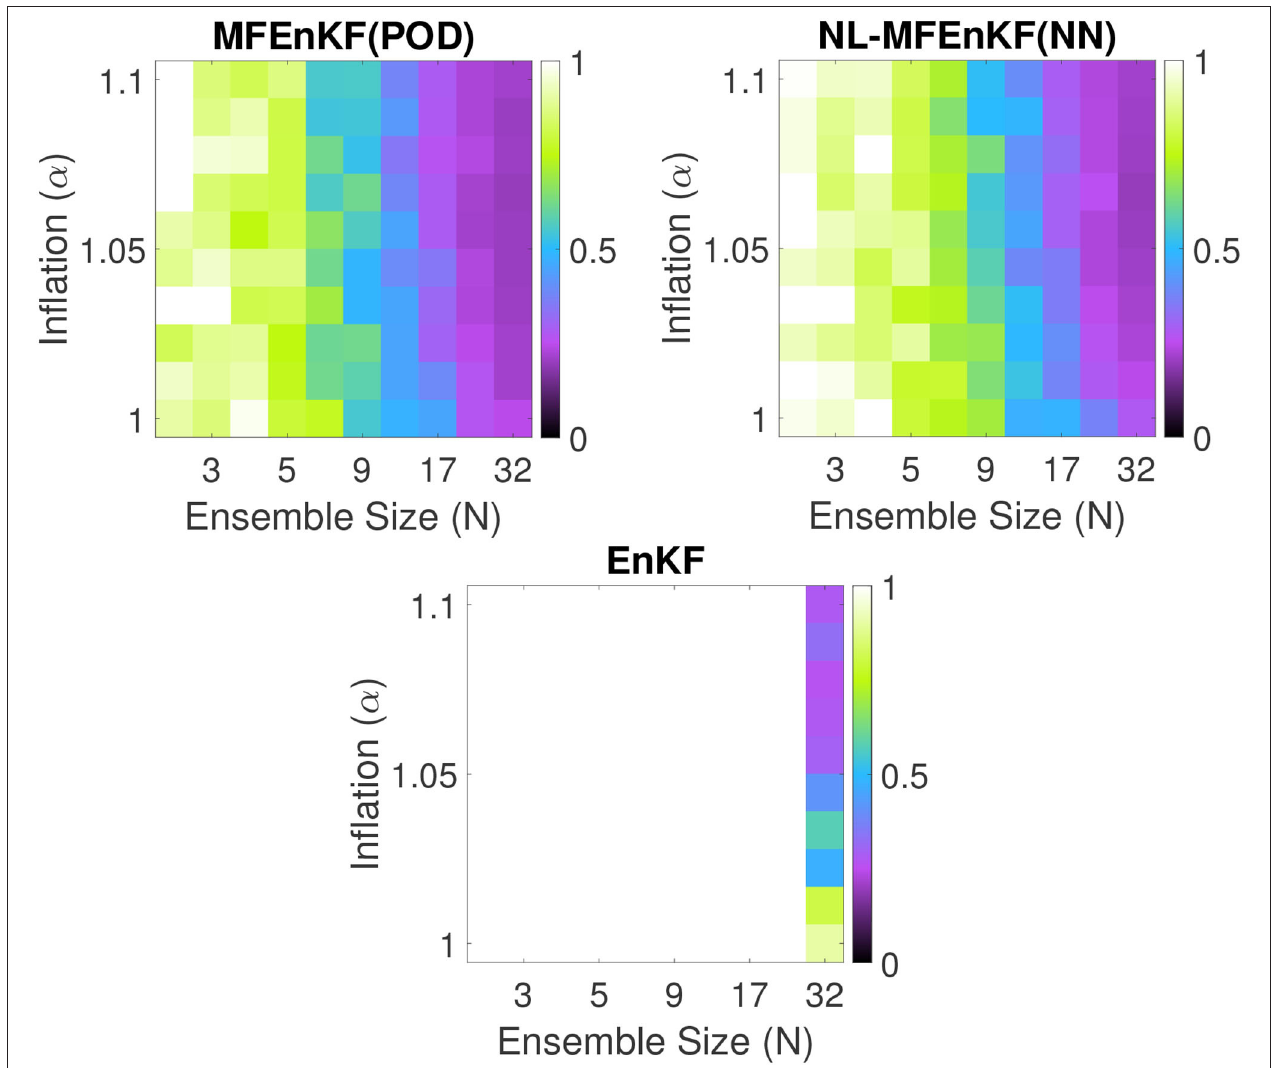
FIGURE 5 | QGE analysis RMSE for four data assimilation algorithms and various values of the principal ensemble size N X and inflation factor α X . The surrogate ROM size is fixed to r = 25 with ensemble size of N U = 12 and inflation of α U = 1.05. The (top left) represents the MFEnKF with a POD-ROM surrogate, the (top right) represents the NL-MFEnKF with a NN-ROM, and the (bottom) represents the classical